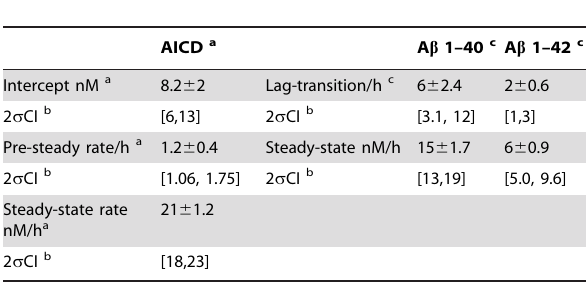
Table 1. Kinetic parameters for pre-steady state burst and initial lags (Fig. 1) a,